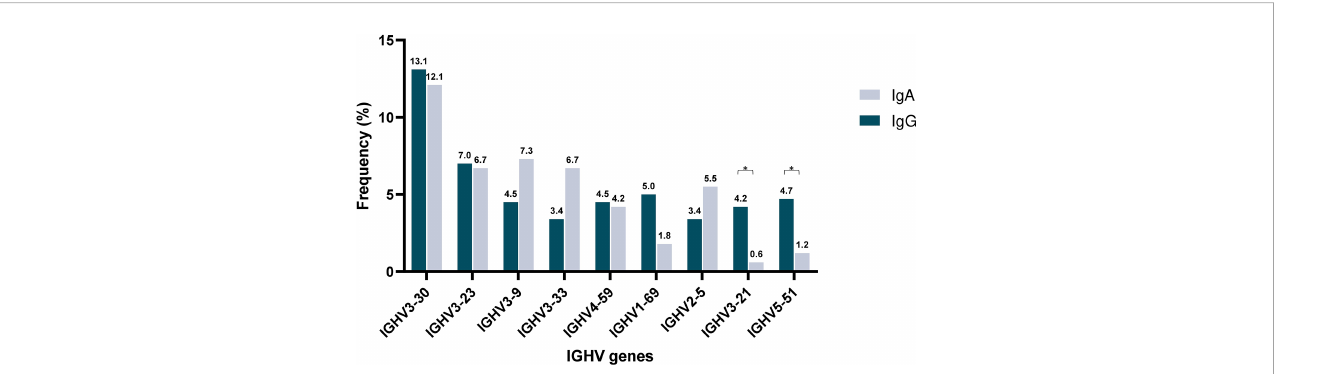
FIGURE 1 Shared and unique IGHV gene repertoires in IgA versus IgM multiple myeloma. Comparison of the most frequently used IGHV genes in IgA (blue) and IgG (gray) MM patients. Asterisks indicate the statistically signi fi cant differences between the two groups (p-value ≤